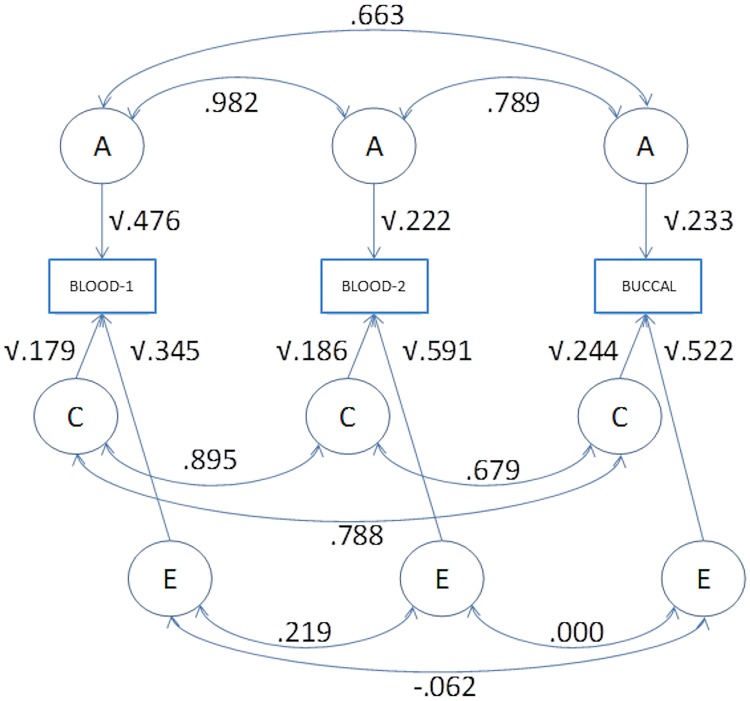
Path diagram depicting the A, C, and E variance components calculated for each of the sample groups.